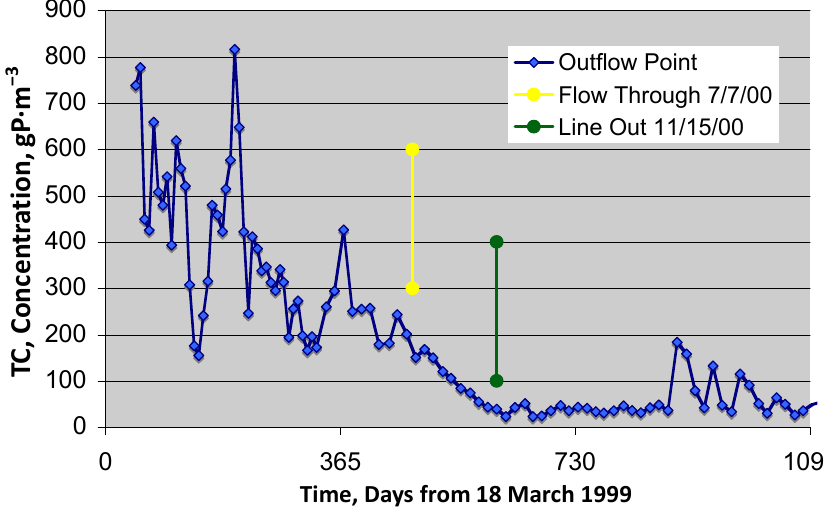
Figure 10. Startup of STA1W Cell 5, beginning18 March 1999.